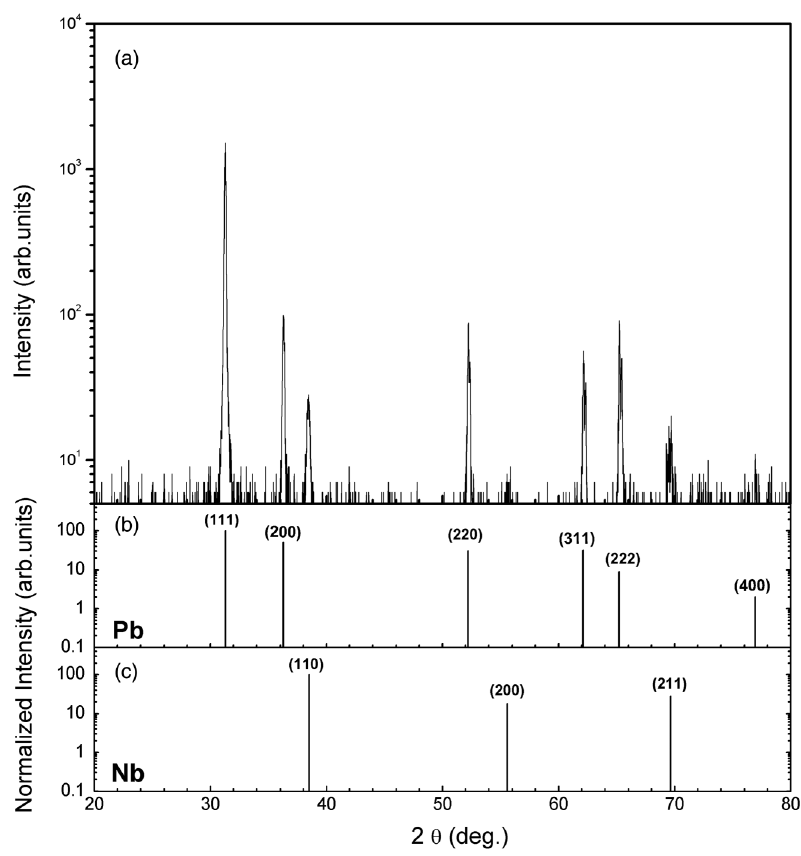
FIG. 5. XRD pattern of the Pb film deposited with a pulse duration of 0.5 ps and an energy density of 0 : 09 J = cm 2 (a); normalized patterns of pure Pb (b), and Nb (c) powders [11].